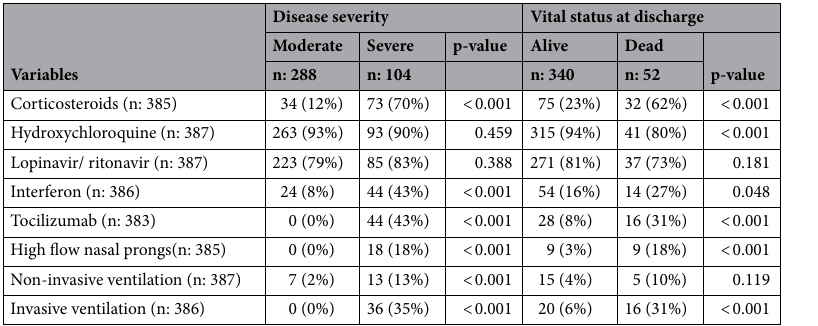
Table 4. Bivariate analysis of hospital treatment according to the development of severe disease and status at discharge. In each variable, total number of valid data is specified in the first column. In each outcome, absolute frequency, percentage by outcome and p-values for the comparation of moderate vs severe disease and alive vs dead at discharge are shown. In bold and italic those associations that are statistically significant.